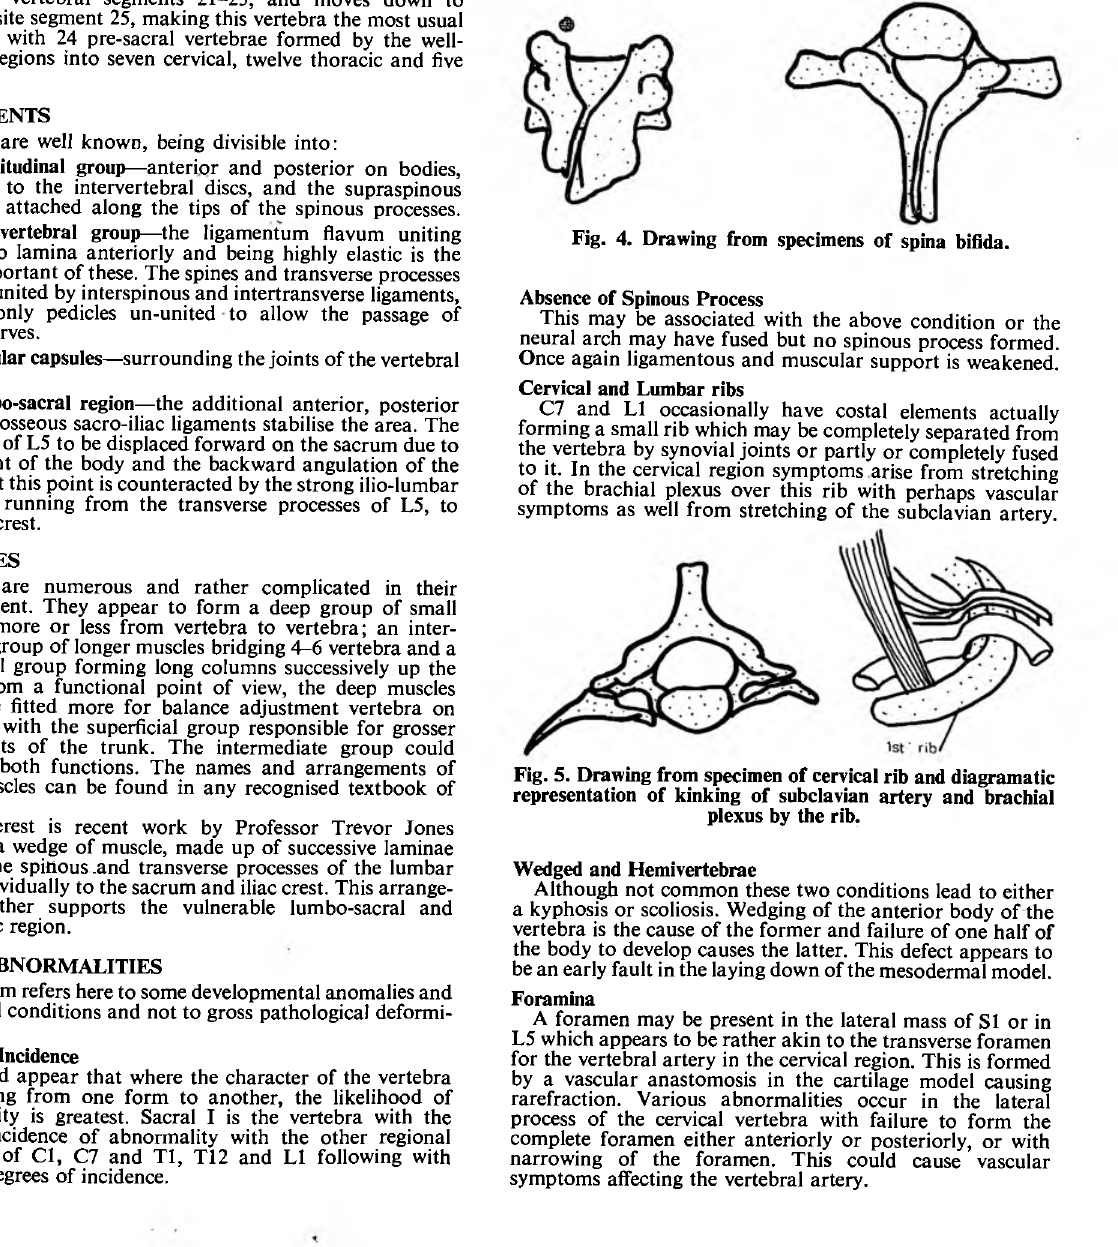
Fig. 4. Drawing from specimens of spina bifida.